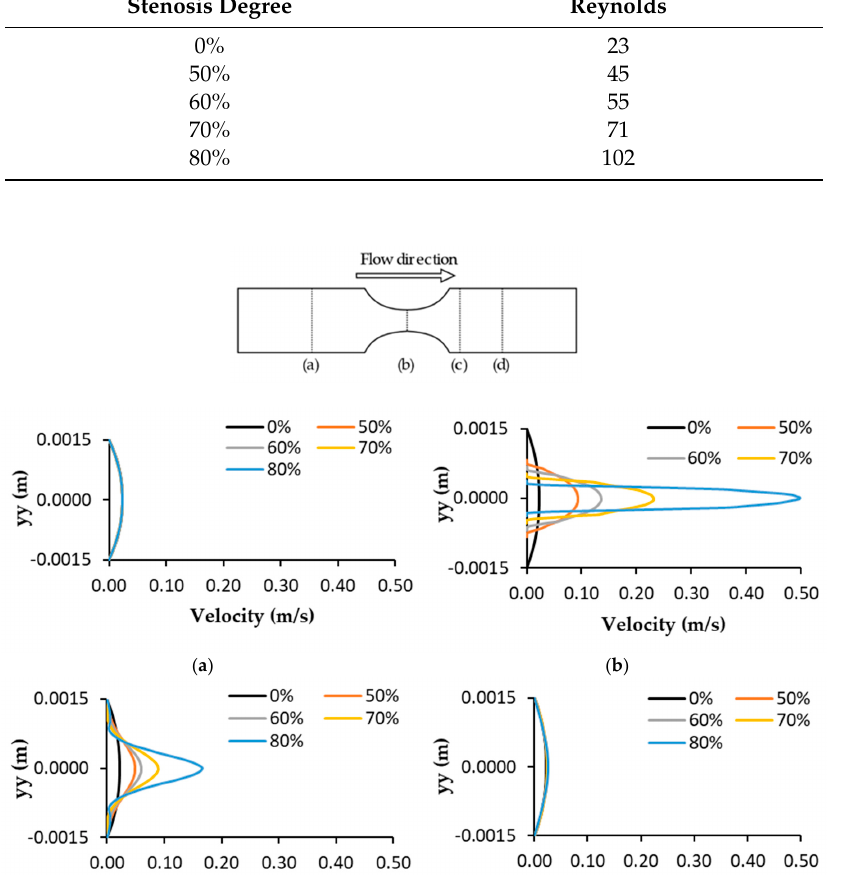
Figure 8. Comparison of velocity profiles at different axial positions for the different degrees of stenosis: ( a ) before stenosis, ( b ) stenosis throat, ( c , d ) after stenosis.